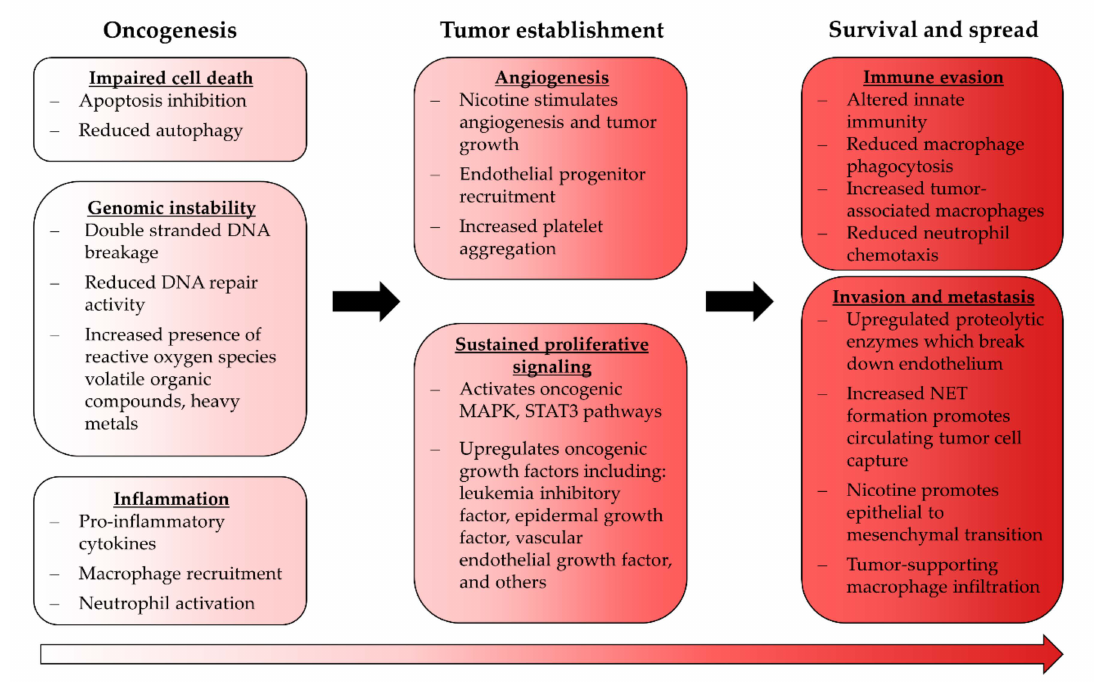
Figure 2. Effects of ECA exposure relating to cancer. Some ECA-induced phenotypical changes are consistent with tumor- supporting processes and may indicate that EC use carries a risk of carcinogenesis; however, the severity of this risk has yet to be